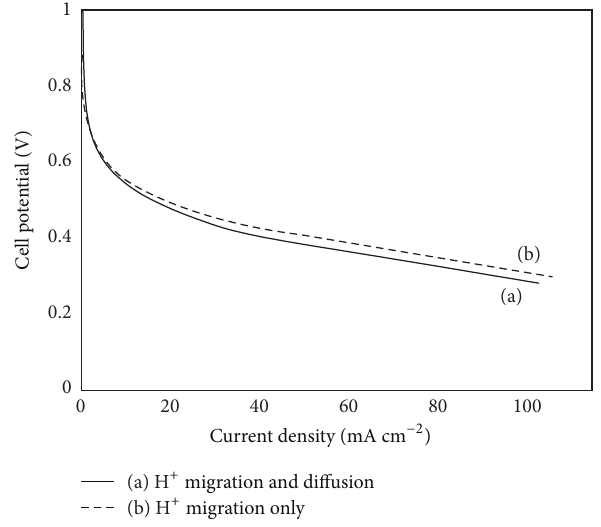
Figure 10: Modeling results for polarization curves of direct propane/oxygen fuel cells using a solid ZrP-PTFE electrolyte at 150 ∘ C. (a) Proton migration and diffusion within the electrolyte phase (the present model). (b) Proton migration only within the electrolyte phase [5].